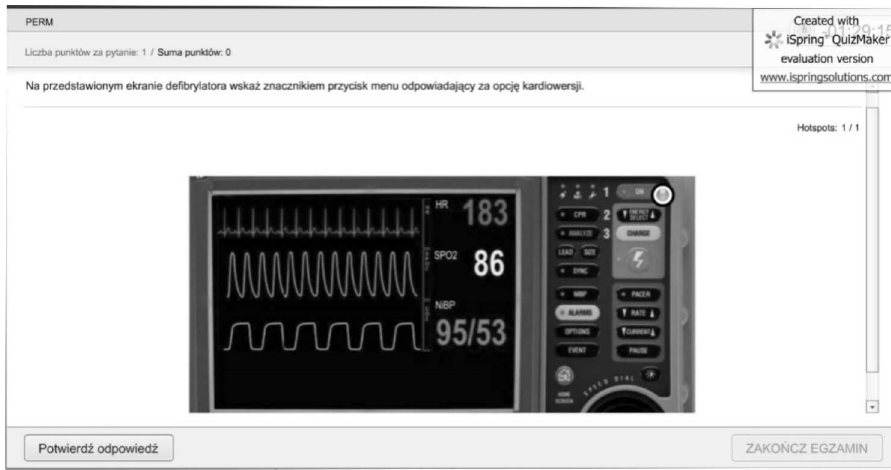
Figure 3. Use of virtual medical equipment